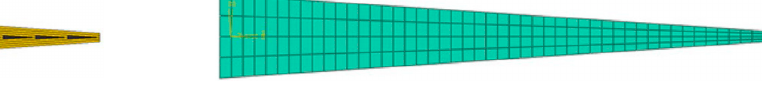
Figure 4. Mesh refinement of rotating region: ( a ) refined mesh, ( b ) vorticity contour, ( c ) refined mesh region.